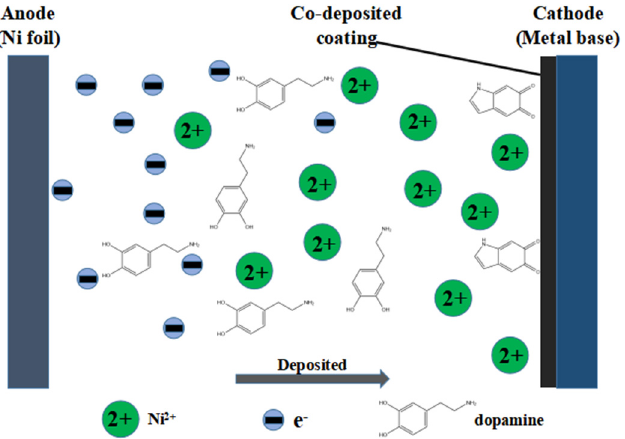
Figure 1. Schematic diagram for fabrication of PDA coating by one-step electrodeposition.